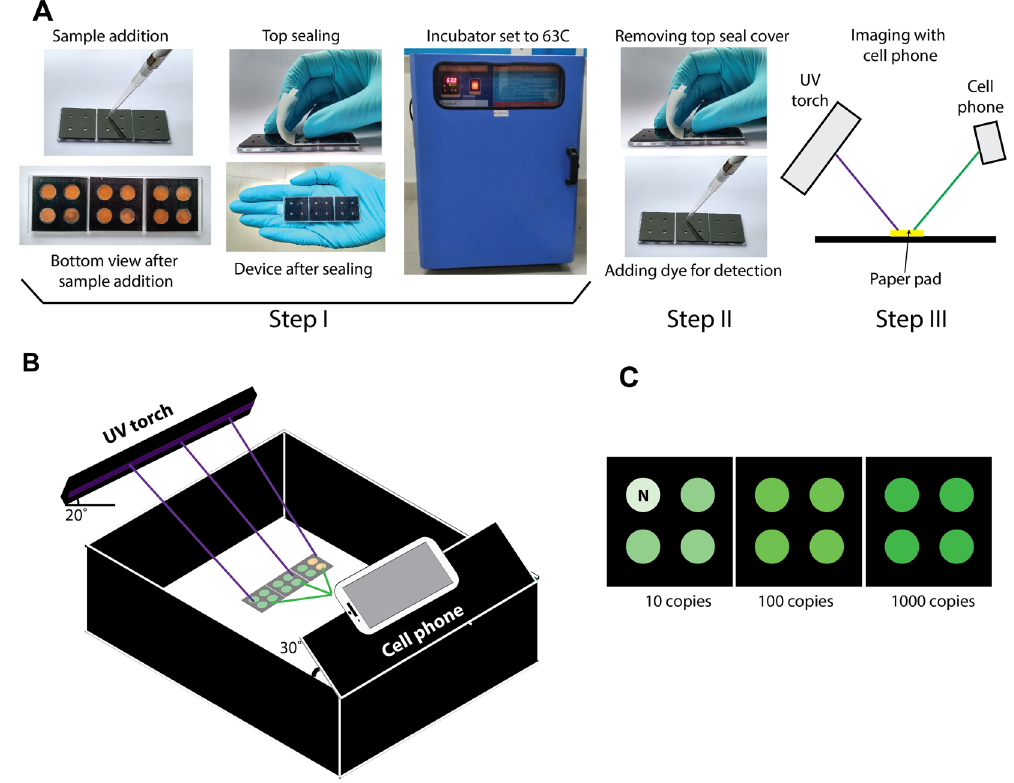
Figure 2. User experience of conducting a NAAT in FLIPP-NAAT. ( A ) User steps involved in operating FLIPP- NAAT. Step I: Sample addition to FLIPP-NAAT, sealing the device and placing it in an incubator set to the reaction temperature. Step II: Removing FLIPP-NAAT from the incubator and adding the DNA intercalating dye. Step III: A UV torch is used for excitation and results are captured using a cell phone camera. ( B ) Schematic of an inexpensive imaging set-up for end-point fluorescence detection. ( C ) Schematic of expected TB test results from FLIPP-NAAT. In one implementation, green fluorescence intensity increases with increasing number of target